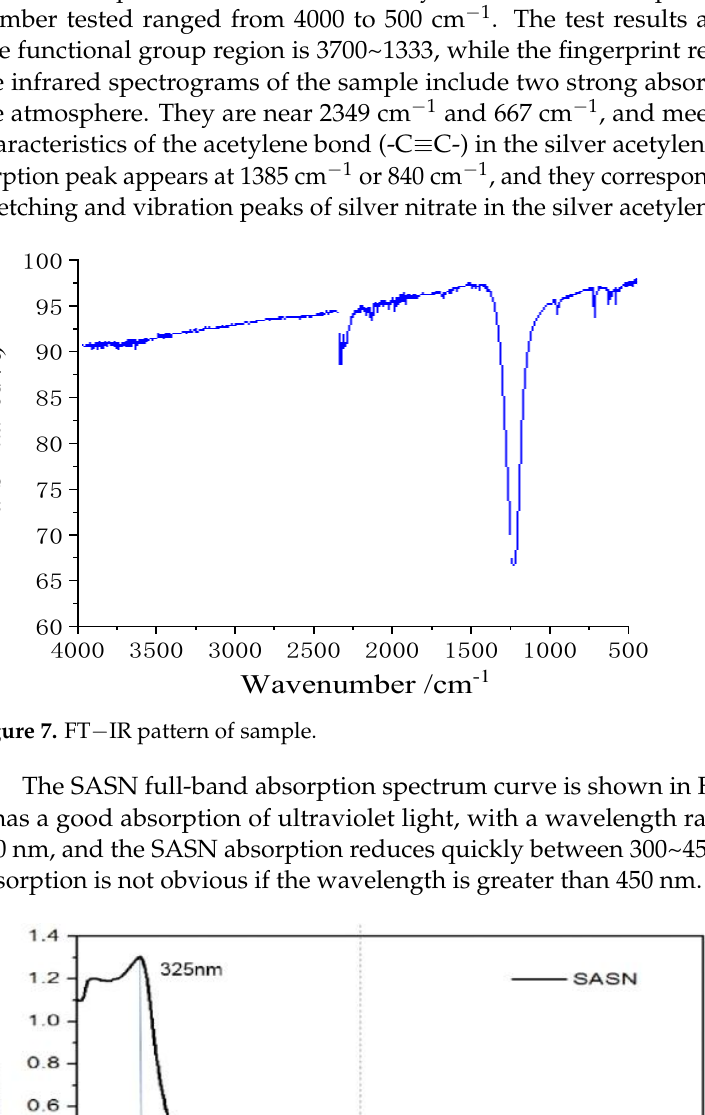
Sample 1 Figure 6. XRD pattern of sample. The sample was tested in infrared by a Fourier infrared spectrometer, and the wave number tested ranged from 4000 to 500 cm − 1 . The test results are shown in Figure 7. The